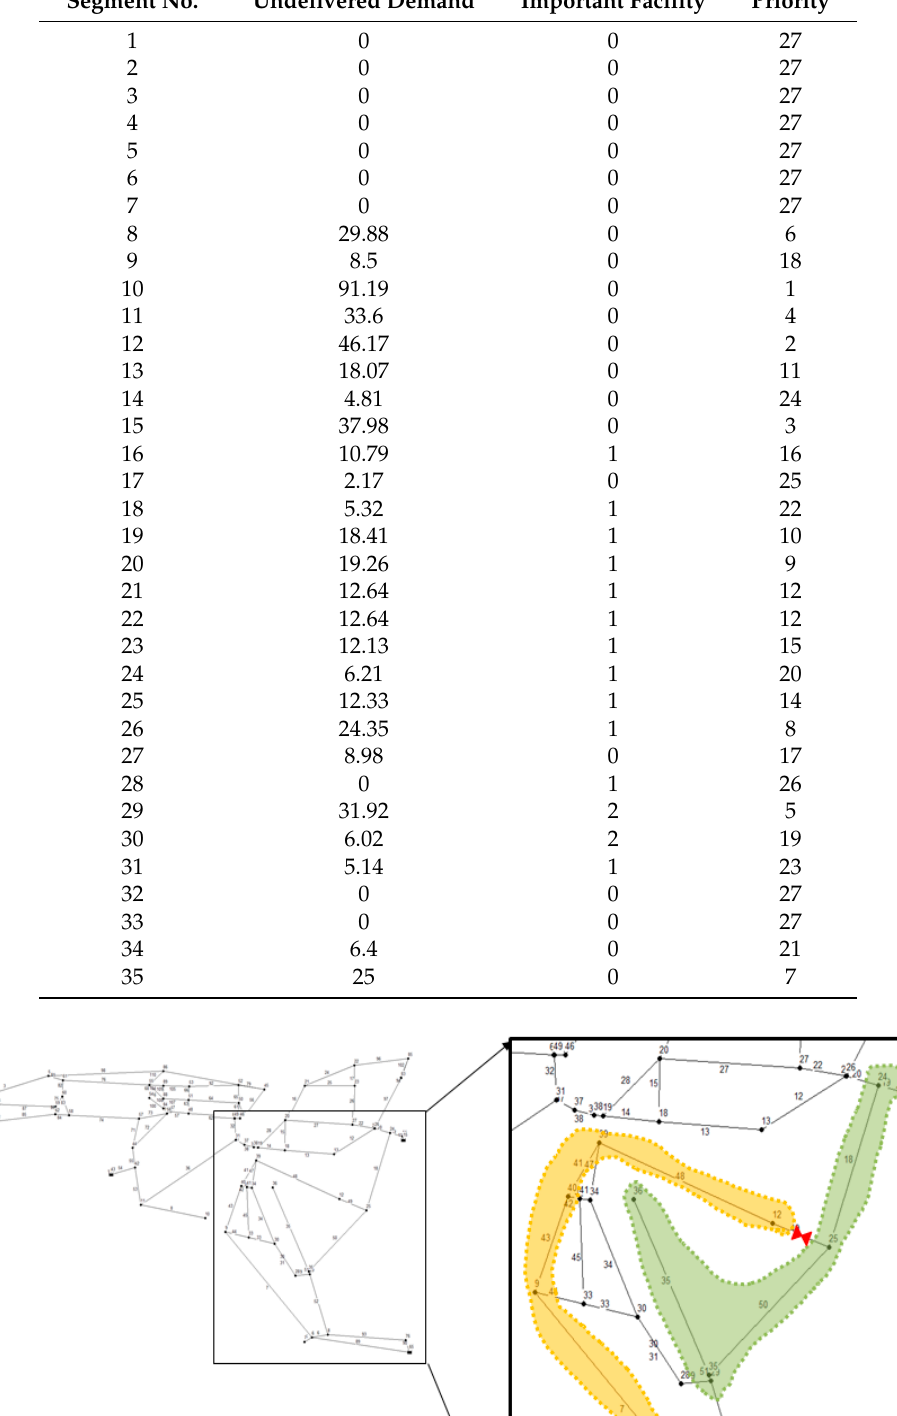
Table 7. Priority of segment division.